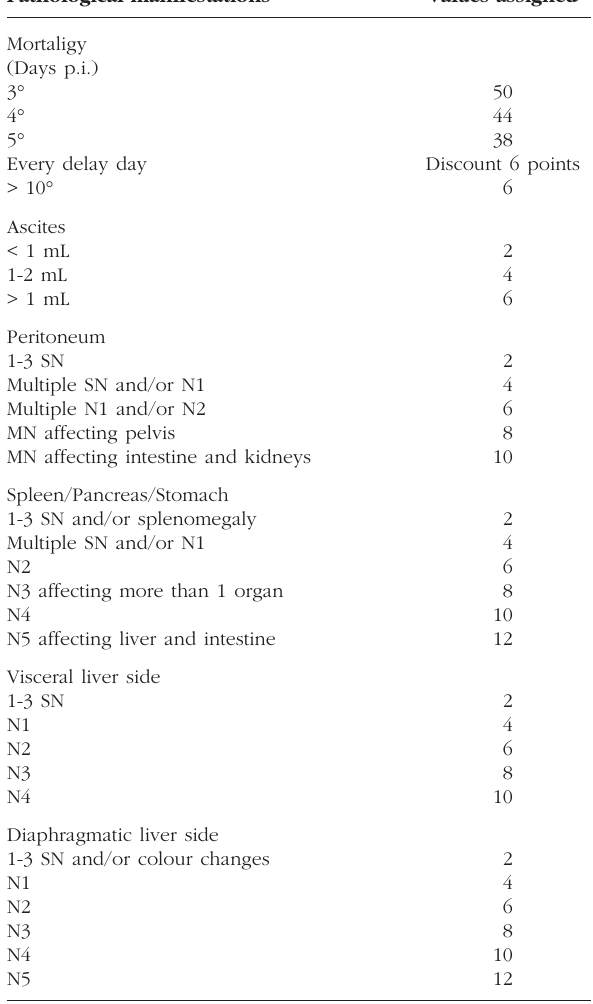
Table I – Rating of pathological manifestations in mice infected by the intraperitoneal route with Trichomonas